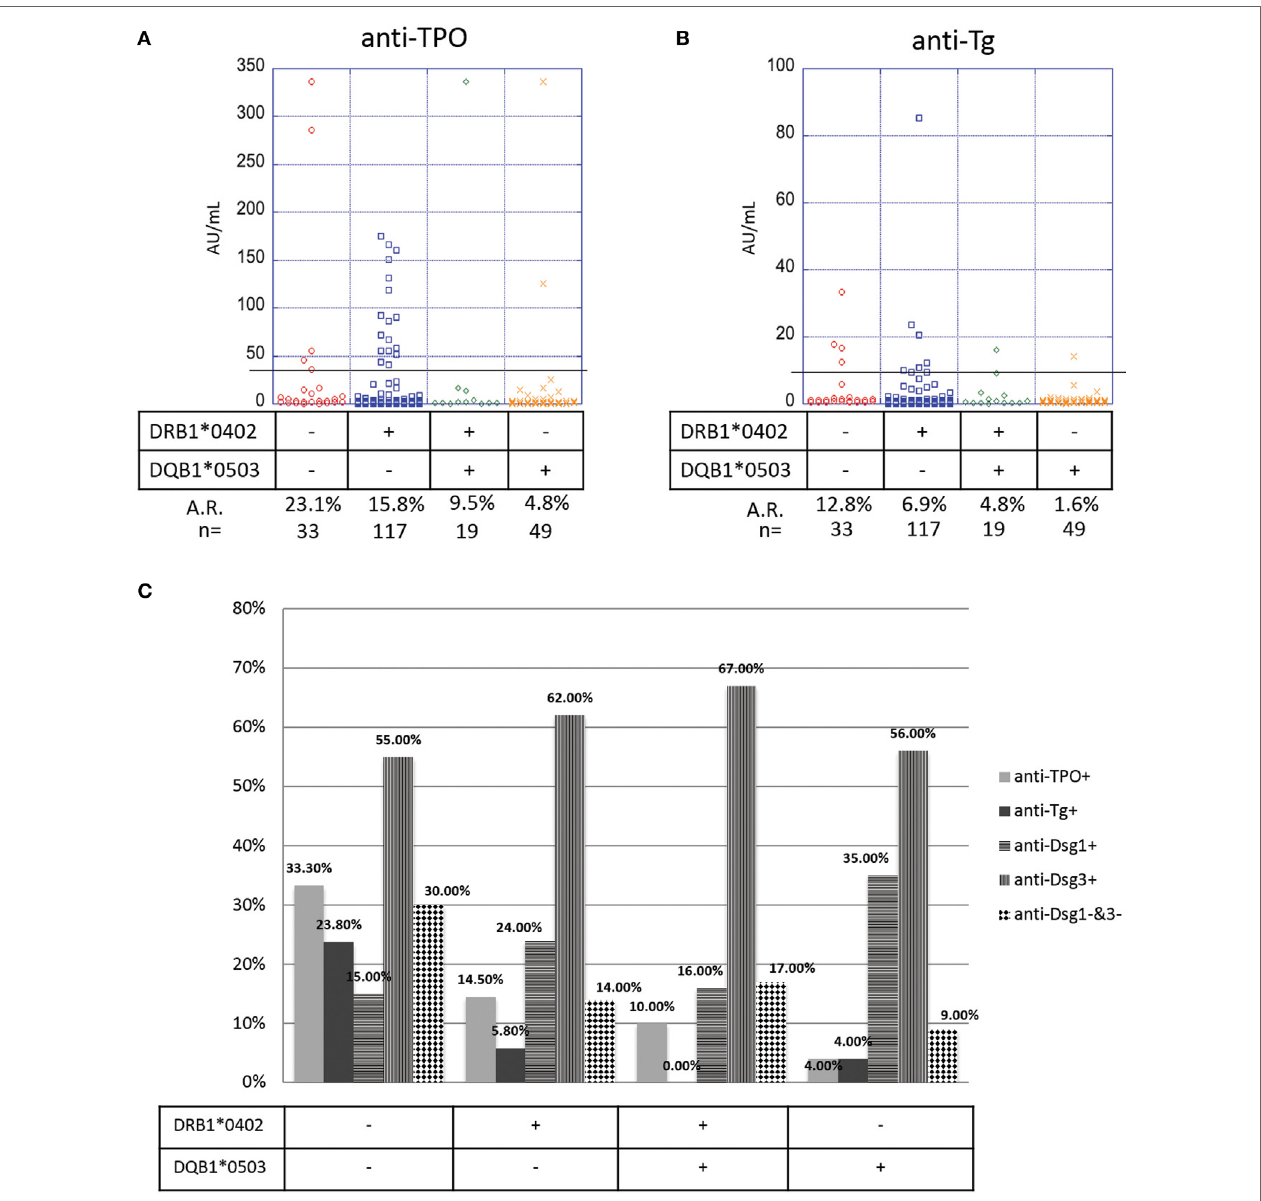
FigUre 5 | Correlation of anti-thyroid peroxidase (anti-TPO), anti-thyroglobulin (anti-Tg), anti-Dsg3, and anti-Dsg1 levels and human leukocyte antigen (HLA) status. Levels of (a) anti-TPO and (b) anti-Tg antibodies in pemphigus vulgaris (PV) patients, subgrouped on the basis of presence or absence of PV-associated HLA susceptibility alleles. Individual dots represent anti-TPO and anti-Tg levels (in AU/ml). Anti-TPO and anti-Tg antibody rates were modeled as a function of absence or presence of the PV-associated HLA alleles DRB1*0402 and/or DQB1*0503 using a generalized estimating equations logistic regression model. (c) Percent positivity of anti-Dsg1, anti-Dsg3, anti-TPO, and anti-Tg in active PV patients, subgrouped based on the presence or absence of the two PV-associated HLA alleles DRB1*0402 and DQB1*0503. The association between HLA and Dsg status was evaluated using Fisher’s exact